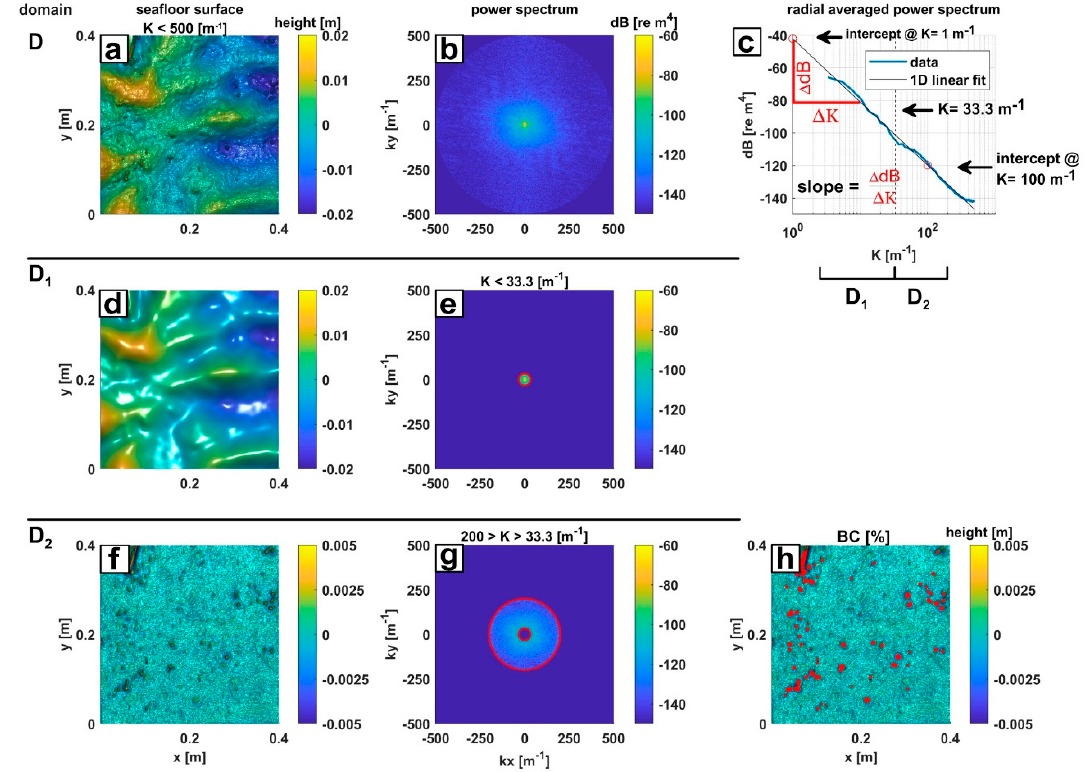
Figure 3. An example of a measured surface by the laser line scanner is displayed in ( a ), while ( b ) shows the corresponding power spectral density (PSD) containing the wavelength interval D (0.002–0.17 m). The blue line in ( c ) shows the radial averaging PSD of ( b ). The black line in ( c )represents the linear fit of the radial averaged PSD required to derive the spectral slope γ and the spectral intercepts at the wavelengths 0.01 m and 1 m. The vertical dashed line in ( c ) indicates the separation of the spectrum D into the intervals D 1 and D 2 , which is equivalent to separation of the PSD demonstrated in ( d )–( g ). The inverse transform of the low-pass filtered PSD D 1 interval is shown in ( d ) with the corresponding spectrum in ( e ). The inverse transform of the PSD D 2 covering wavelength < 0.03 m is shown in ( f ), with the corresponding high-pass filtered spectrum in ( g ). The red circles in ( e ) and ( g ) indicate the cuto ff wavelength. The red markers in ( h ) highlight the detected objects from ( f ), which were used to compute the benthic coverage (BC).